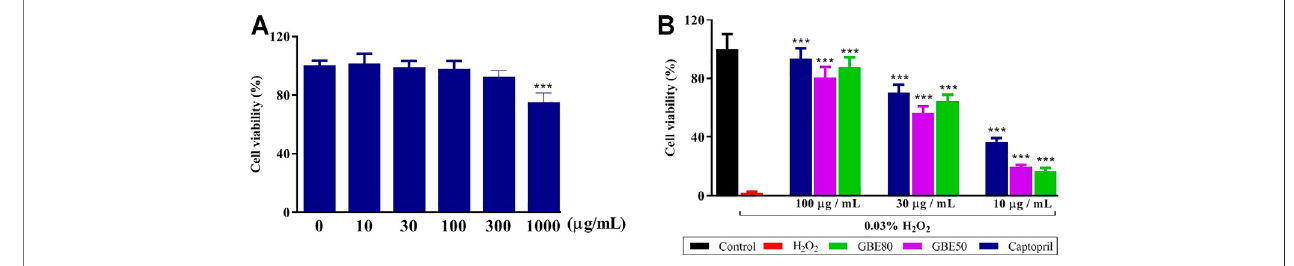
FIGURE 1 | GBE80 treatment reduces oxidation-induced injury in cardiomyocytes. Cardiomyocyte viability and protective effect following exposure of the cells to GBE80 alone (A) or different treatments under H 2 O 2 injury (B) , respectively. (*** indicates p < 0.001 vs the control group (A) or H 2 O 2 group (B) ,